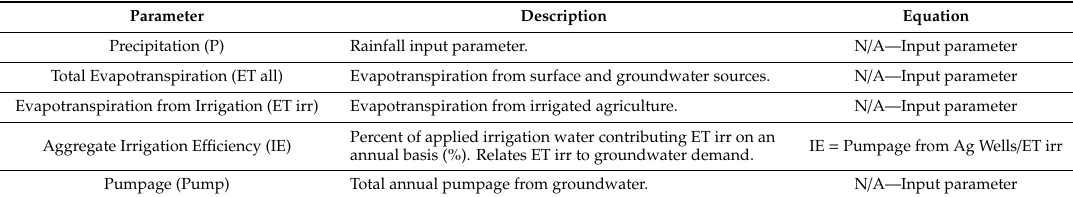
Table 2. Cuyama groundwater system input parameters and equations [17].